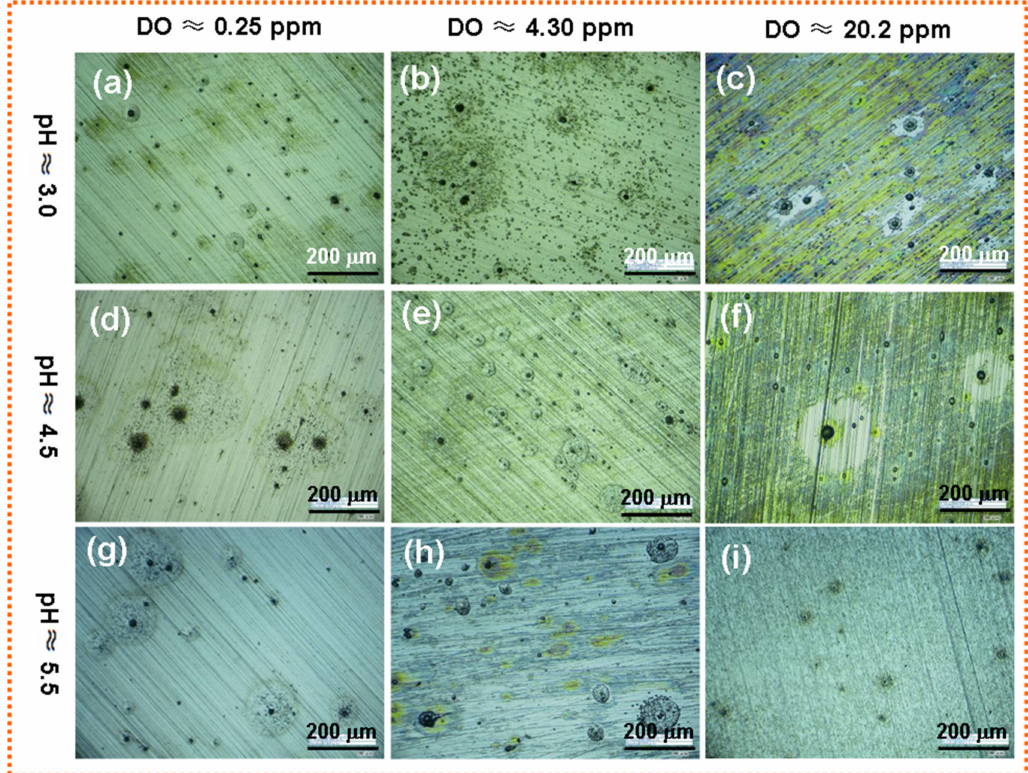
Figure 3. Surface OM image of X80 steel after EIS test in the acidic soil simulated solution with various pH and DO content. ( a ) pH ≈ 3.0 and DO ≈ 0.25 ppm; ( b ) pH ≈ 3.0 and DO ≈ 4.30 ppm; ( c ) pH ≈ 3.0 and DO ≈ 20.2 ppm; ( d ) pH ≈ 4.5 and DO ≈ 0.25 ppm; ( e ) pH ≈ 4.5 and DO ≈ 4.30 ppm; ( f ) pH ≈ 4.5 and DO ≈ 20.2 ppm;( g ) pH ≈ 5.5 and DO ≈ 0.25 ppm; ( h ) pH ≈ 5.5 and DO ≈ 4.30 ppm; ( i ) pH ≈ 5.5 and DO ≈ 20.2